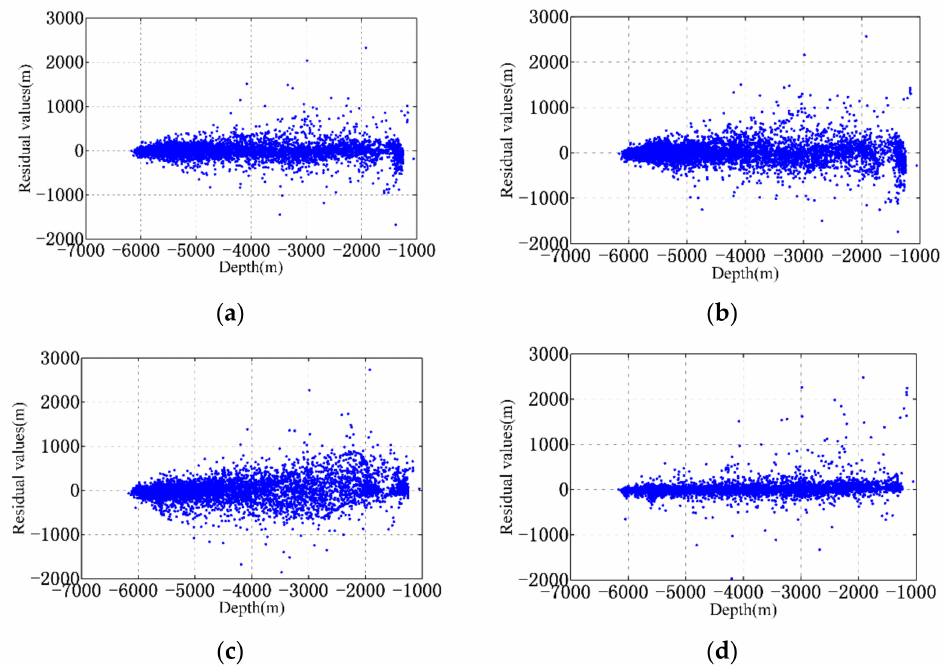
Figure 9. The curve of residual values with depth. ( a ) ST_TCFWO model ( b ) ST_KR model ( c ) ETOPO1 model ( d ) V19.1